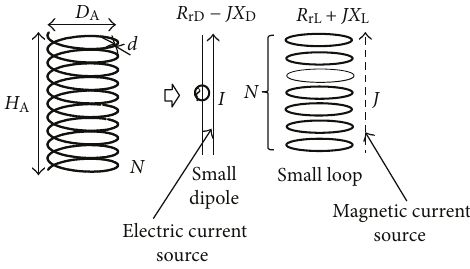
Figure 1: Conceptual equivalence of a normal-mode helical antenna.